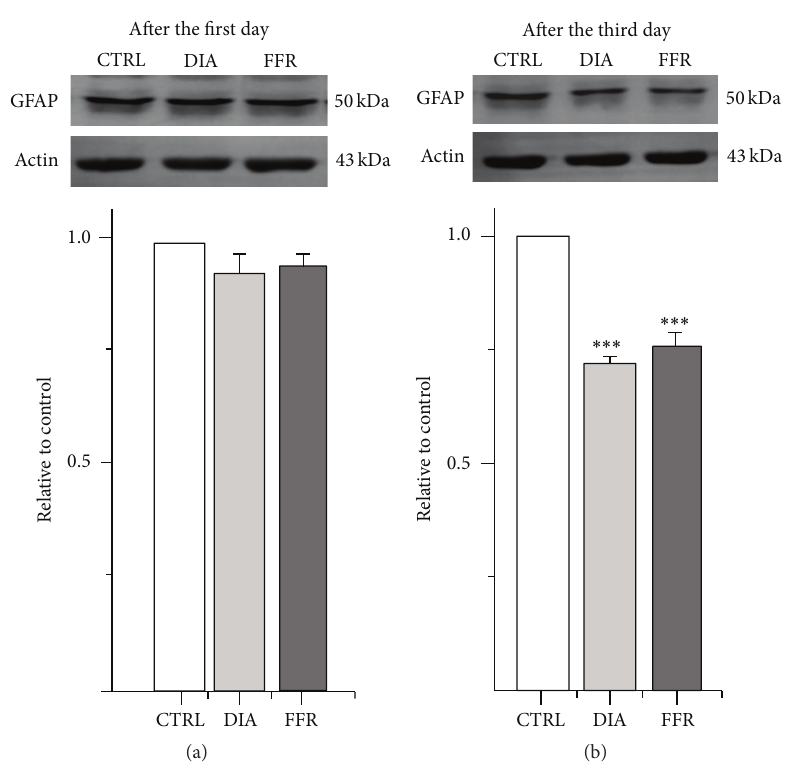
Figure 7: GFAP expression is reduced after the third day. (a, b) Representative Western blot showing the expression of GFAP after the first (a) and third day (b) of anorexia; actin was used as an internal control. The band intensity of DIA and FFR groups was normalized to their respective controls ((a, b) under the Western blots). Data were shown as ± SEM. Significant differences were considered as ∗∗∗ 𝑝 < 0.001